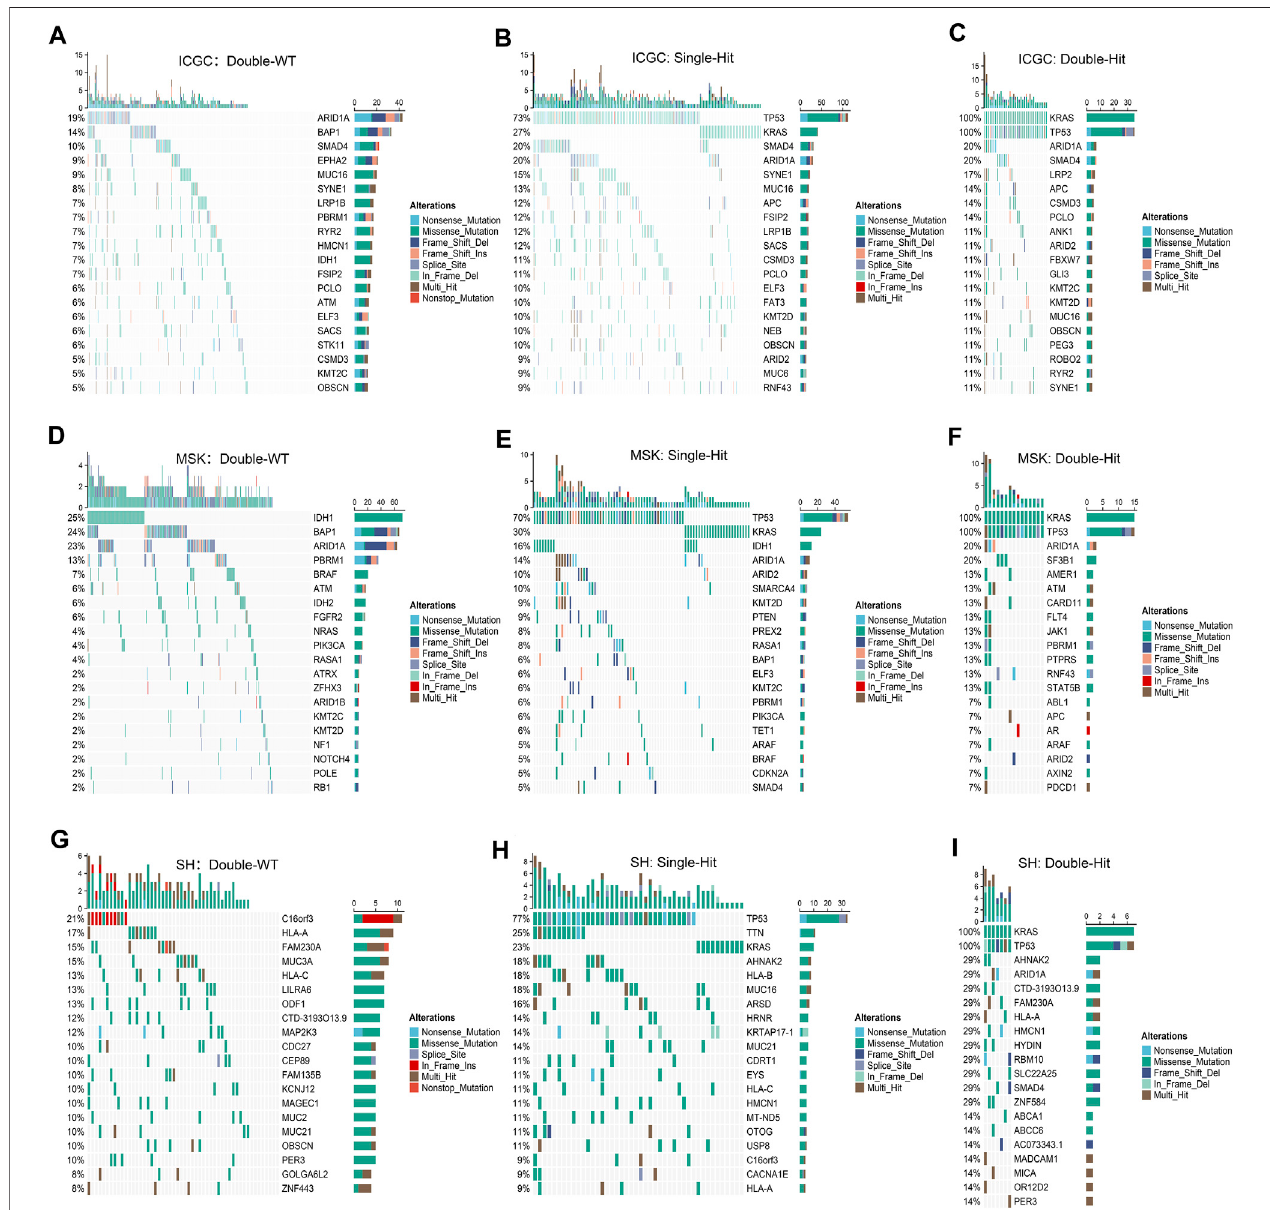
FIGURE 4 | Mutation landscapes of “ Double-WT, ” “ Single-Hit, ” and “ Double-Hit ” phenotypes in the three cohorts. (A – C) In the ICGC cohorts, the mutation landscapesof “ Double-WT ” (A) , “ Single-Hit ” (B) ,and “ Double-Hit ” (C) phenotypes. (D – F) Oncoplot depictstheFMGs forthethree phenotypesintheMSK cohort. (G – I) Oncoplot depicts the FMGs for the three phenotypes in the SH